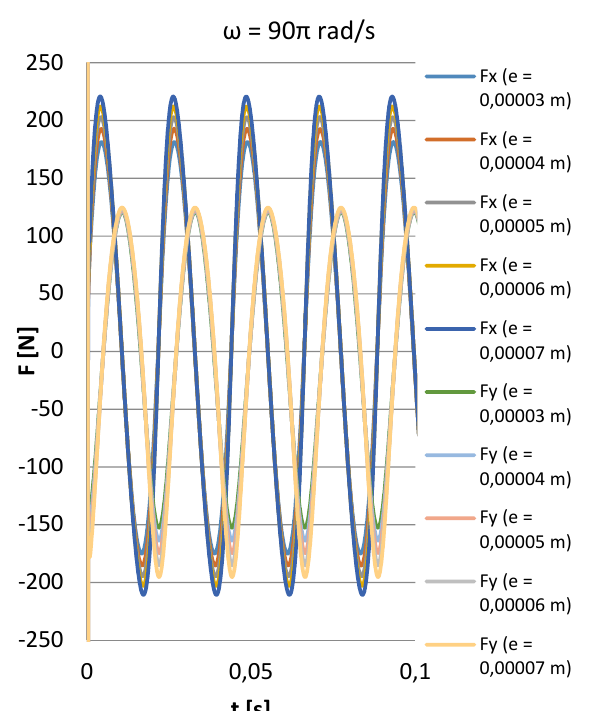
Fig. 7. Force components for ω = 90 π rad/s